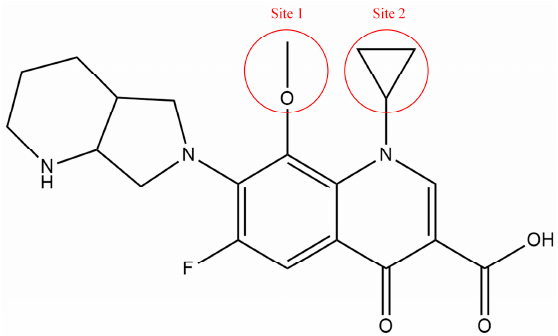
Figure 2. The molecular structure and the modified sites of MOX.